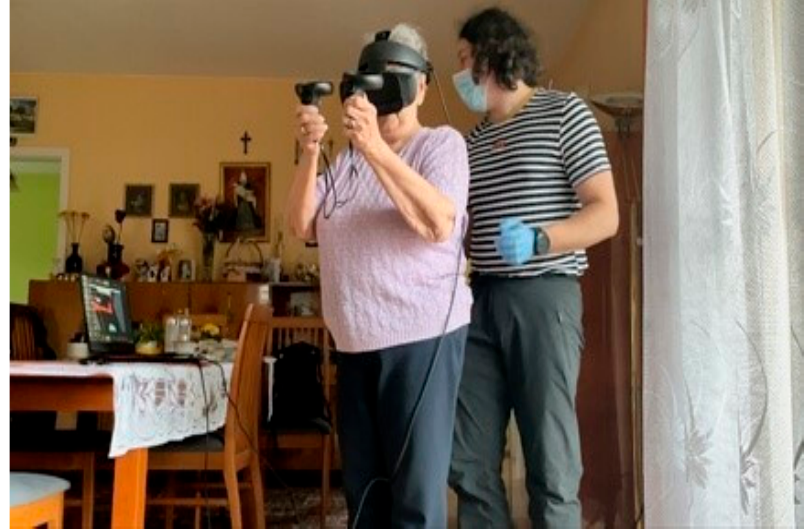
Figure 8. The VR-based intervention making use of the Oculus goggles, assisted by a